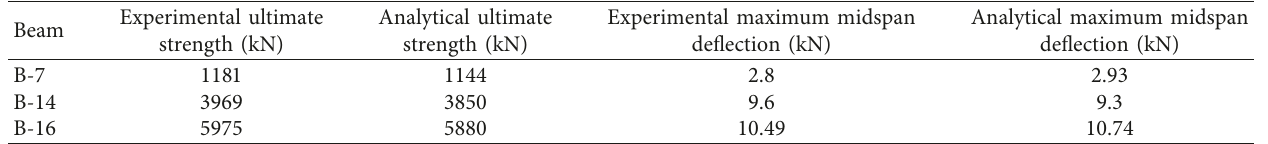
Table 3: Experimental and analytical results for deep concrete beams.